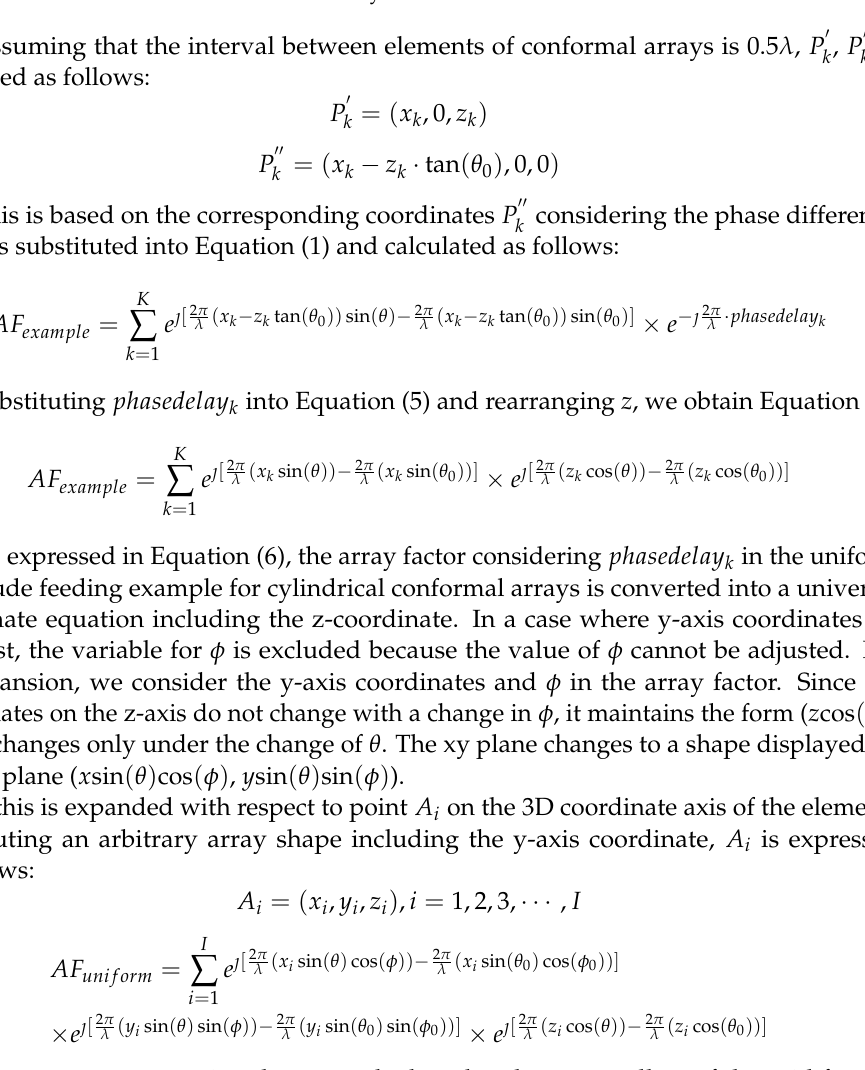
Figure 5. Detailed locations of conformal array